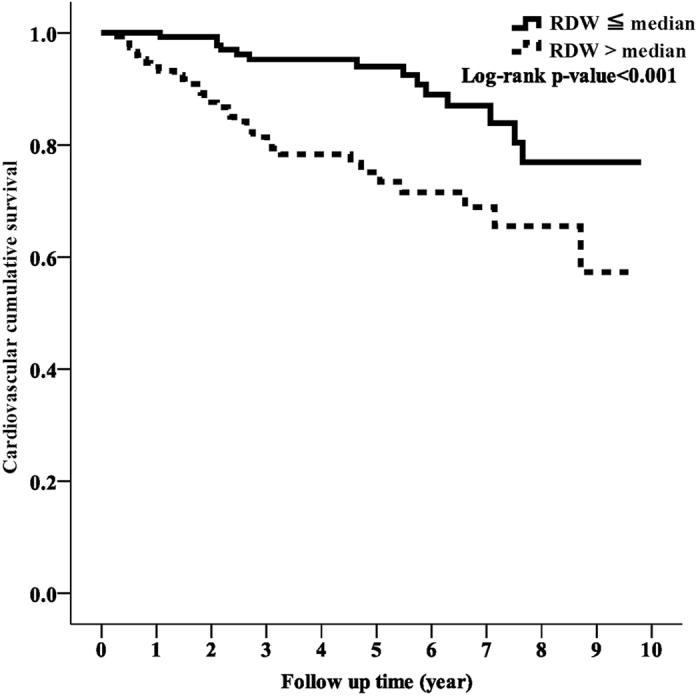
Kaplan-Meier curve of cumulative survival free of cardiovascular disease-related mortality according to the RDW groups (log-rank test, p < 0.001).